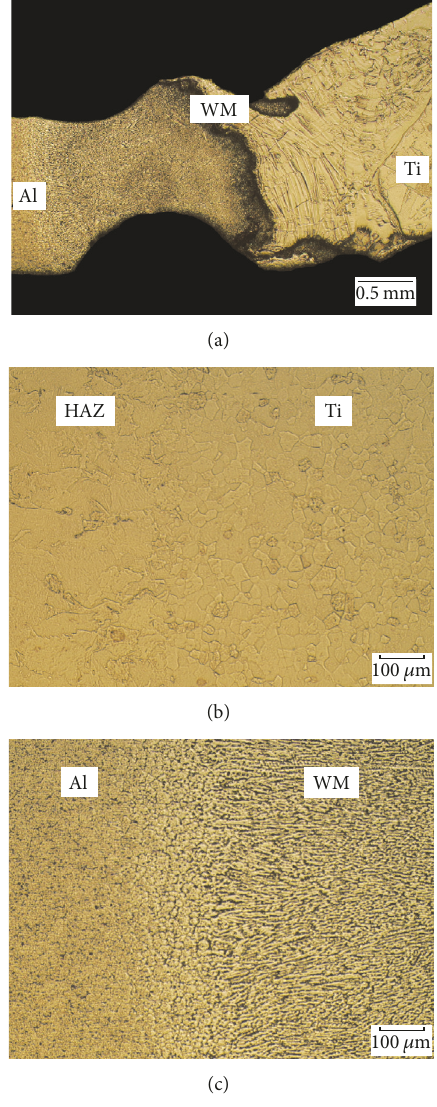
Figure 18: Macrostructure and microstructure of the weld joint (sample 2): (a) macrostructure of weld joint; (b) HAZ, titanium Grade 2 interface; (c) aluminium alloy, WM